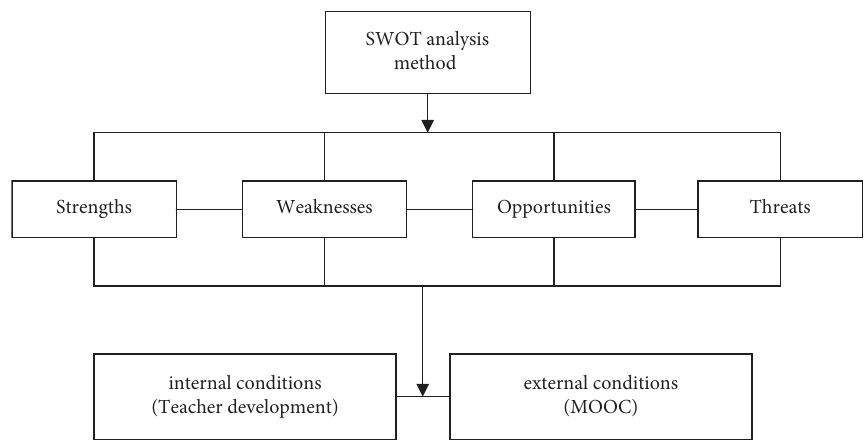
Figure 1: SWOT analysis using the MOOC as external